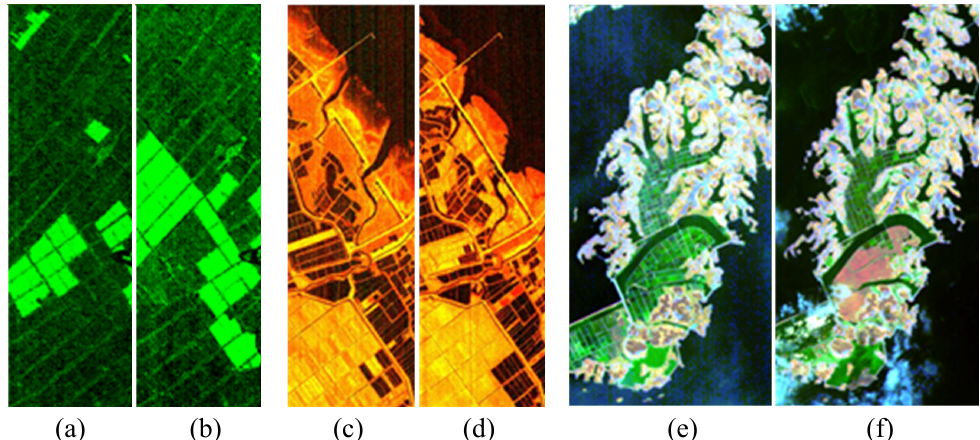
Figure 5. ( a ) The farmland image on 3 May 2006; ( b ) The farmland image on 23 April 2007; ( c ) The countryside image on 3 November 2007; ( d ) The countryside image on 28 November 2008; ( e ) The Poyang lake image on 27 July 2002; ( f ) The Poyang lake image on 16 July